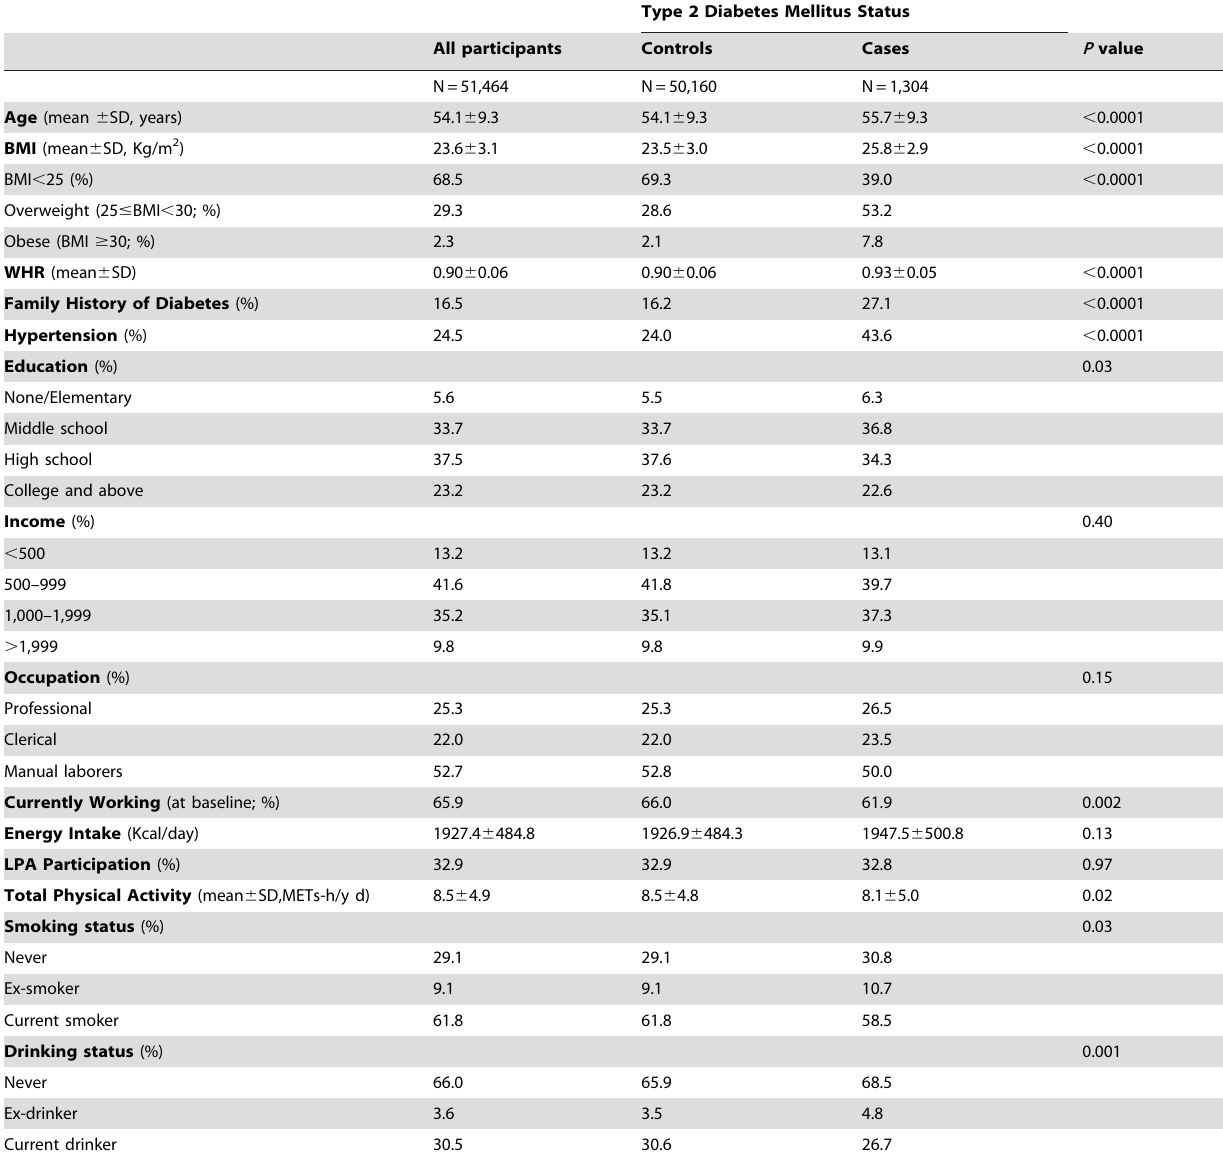
Table 1. Demographic characteristics of participants by T2DM